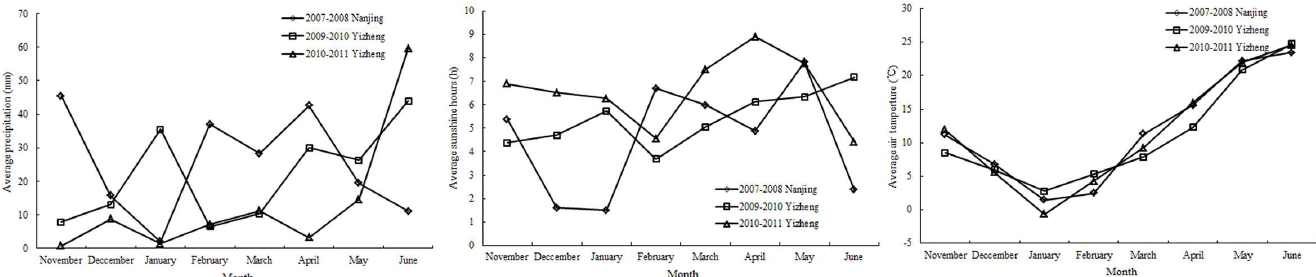
Fig 1. Averagemonthly precipitation (mm), sunshine hours (h), air temperature (˚C) during the three season